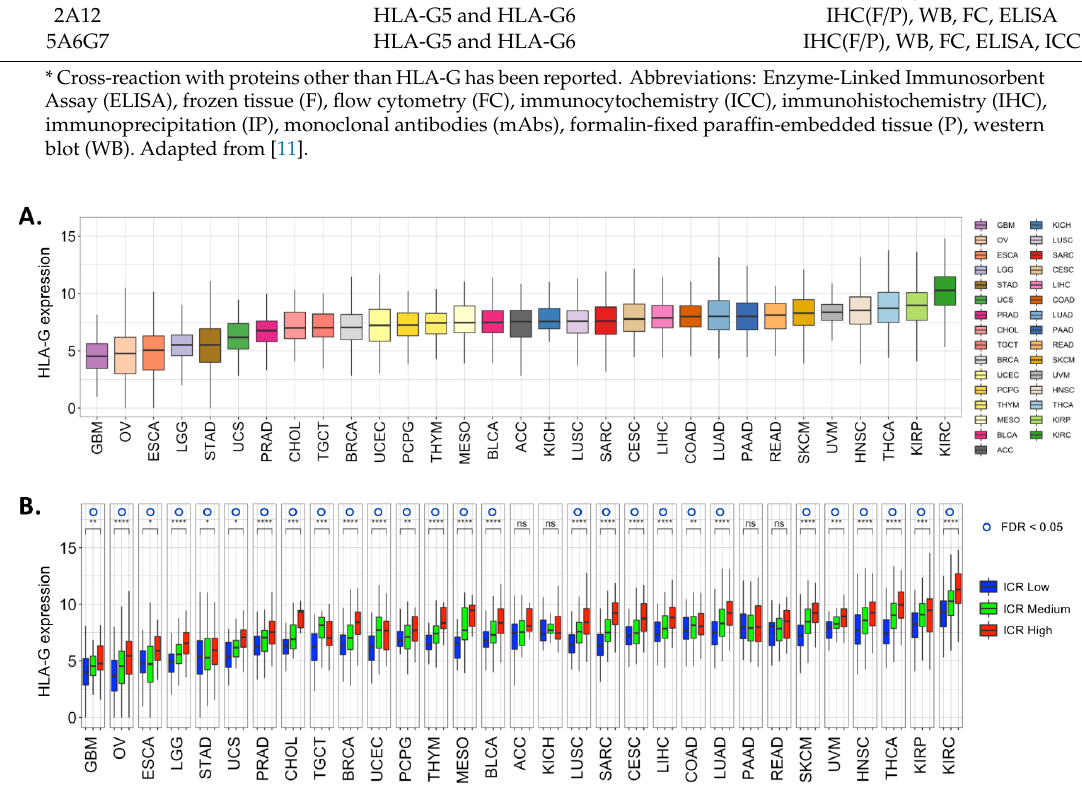
Figure 2. HLA-G mRNA expression in The Cancer Genome Atlas (TCGA) cohort. ( A ) Boxplot of log-transformed pan-cancer normalized gene expression values of HLA-G across 31 solid cancer types from The Cancer Genome Atlas [49]. Cancer types are ordered by mean expression of HLA-G per cancer type. ( B ) Log-transformed pan-cancer normalized gene expression per Immunologic Constant of Rejection (ICR) cluster for each cancer type. Unpaired t -test between HLA-G expression in ICR High versus ICR Low: * p < 0.05, ** p < 0.01, *** p < 0.001, **** p < 0.0001, and ns: not significant. False